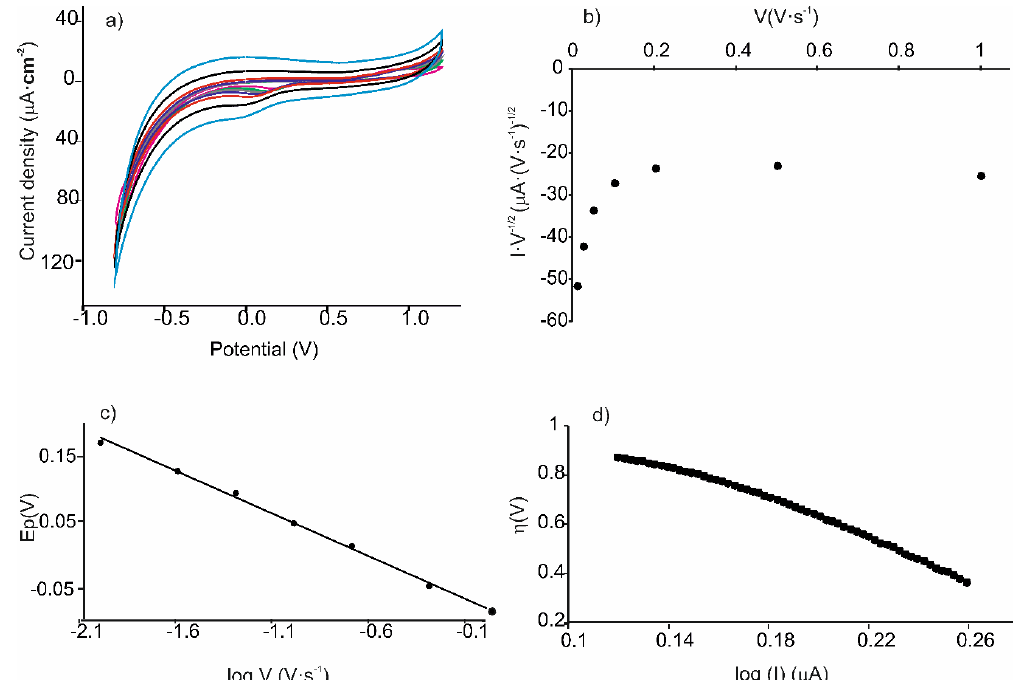
Figure 6. Analysis of the electron transfer mechanism. ( a ) Cyclic voltammograms of AuNP tOcBr /ZnPc RS in catechol 10 − 4 mol∙L − 1 registered at increasing scan rates from 0.01 to 1 V∙s − 1 , ( b ) representation of I· ν − 1/2 vs. scan rate for the cathodic pea, ( c ) variation of peak potentials vs. the logarithm of the scan rates. ( d ) Representation of Tafel plot: overpotential η vs log (I) in cathodic peak. At scan rates lower than 0.20 V∙s − 1 , where the charge transfer is the limiting step, the charge transfer coefficient α can be calculated from the slope of the L aviron equation (Equation (3)). This